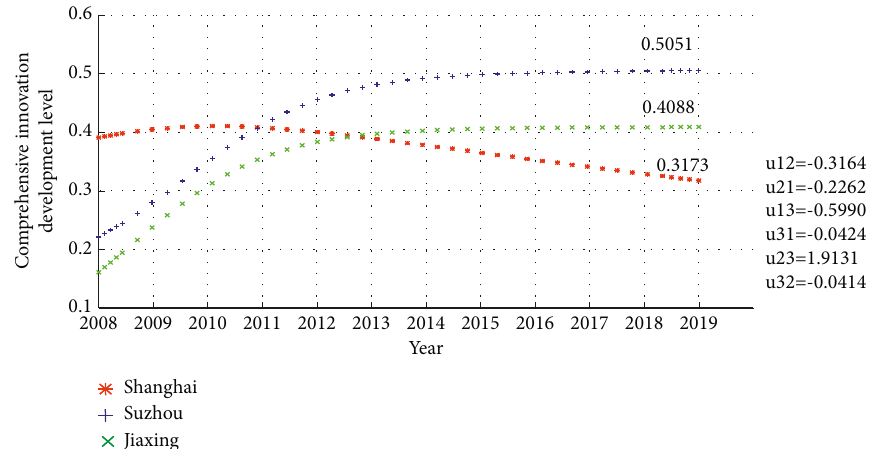
Figure 5: Evolution trend of comprehensive innovation development level under mutual inhibition